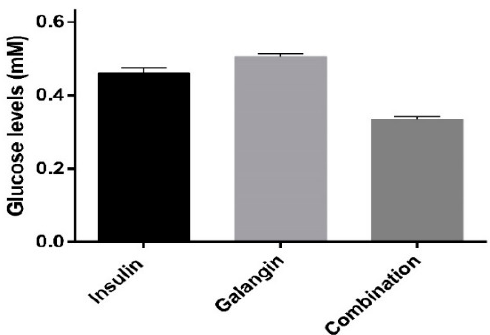
Figure 6. The amount of glucose levels in cell supernatant of rat L6 skeletal muscles treated with different treatments: L6 cell line (control), insulin (10 nM), galangin (250 µg/mL), and in combination (10 nM insulin and 250 µg/mL galangin) for 24 h. All the data are represented as the mean ± standard deviation in triplicate.